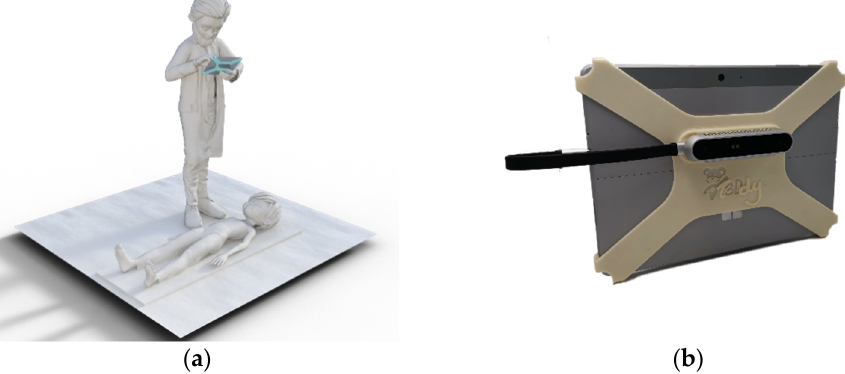
Figure 2. The handheld scanning system: ( a ) CAD model; ( b ) 3D-printed